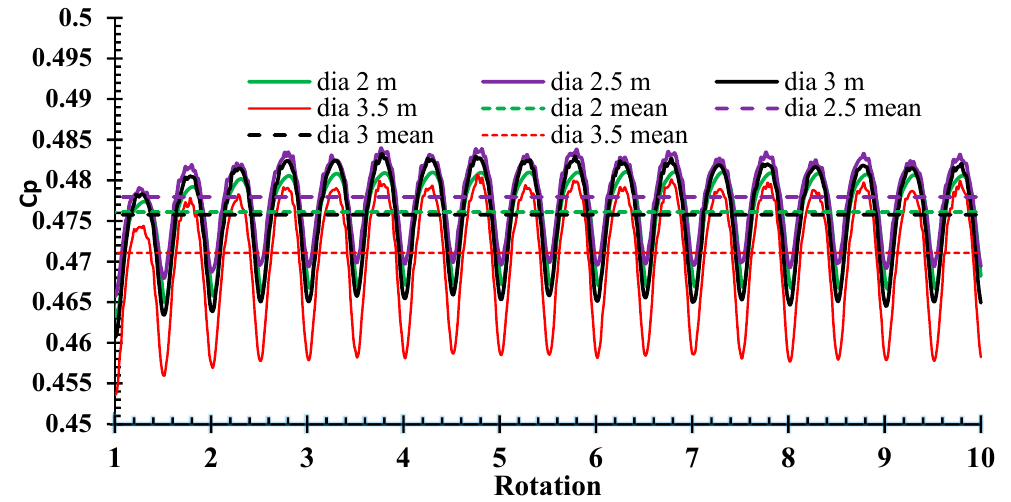
Figure 4. Coefficient of performance for different tower diameter for 10 rotations.